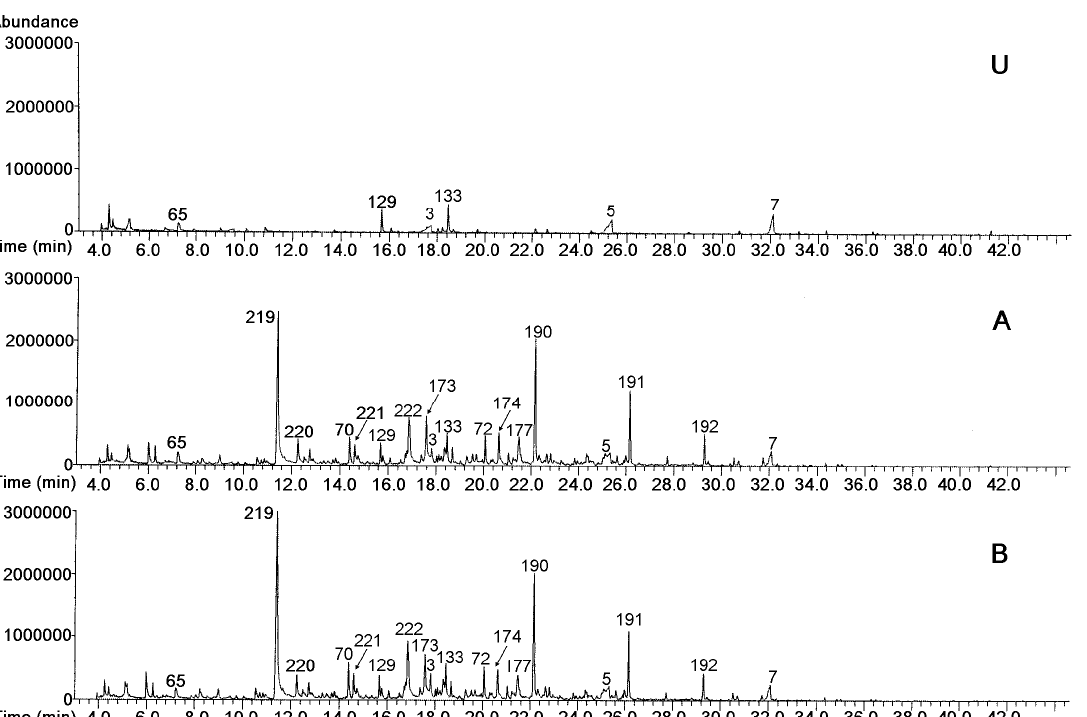
Figure 1. Total ion current chromatogram of the components of the headspace of the unsmoked cheese ( U ), and of the cheeses smoked at positions A and B